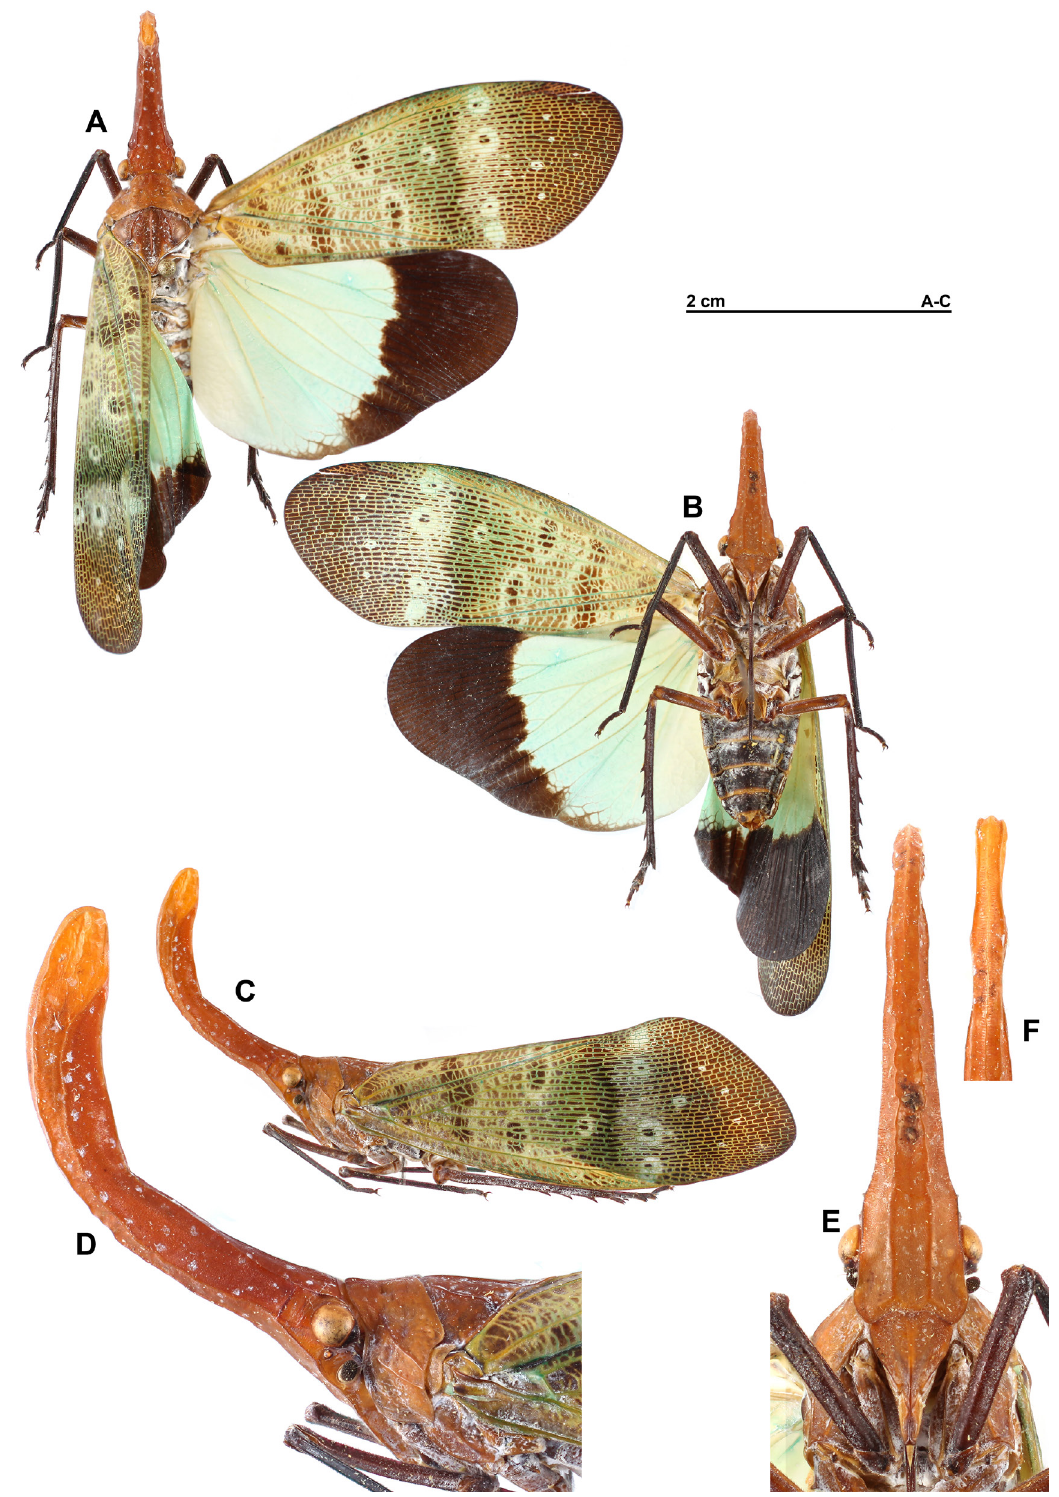
Fig. 17. Pyrops ducalis (Stål, 1863), ♂, Vietnam, Dong Nai Biosphere Reserve, 25 Jun.–6 Jul. 2012 (RBINS). A . Habitus, dorsal view. B . Habitus, ventral view. C . Habitus, lateral view. D . Head and thorax, lateral view. E . Head, perpendicular view of frons. F . Apex of cephalic process, anteroventral view. D–F = not to